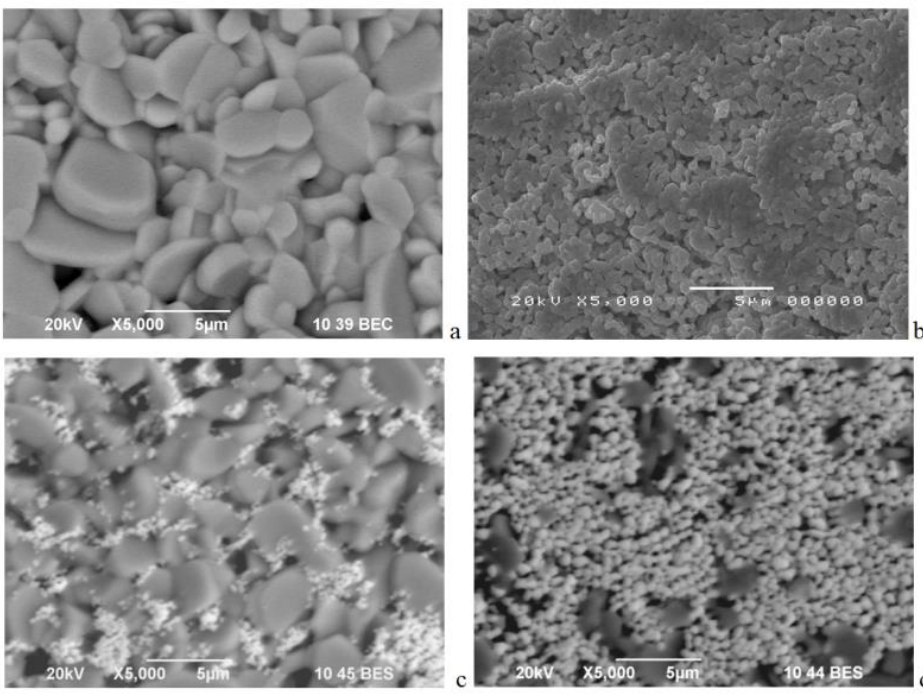
Figure 1. SEM images of Ca 3 Co 4 O 9 ( a ), LaCo 0.8 Ni 0.1 Fe 0.1 O 3 ( b ), LCO20Ca80 ( c ), and LCO80Ca20 ( d